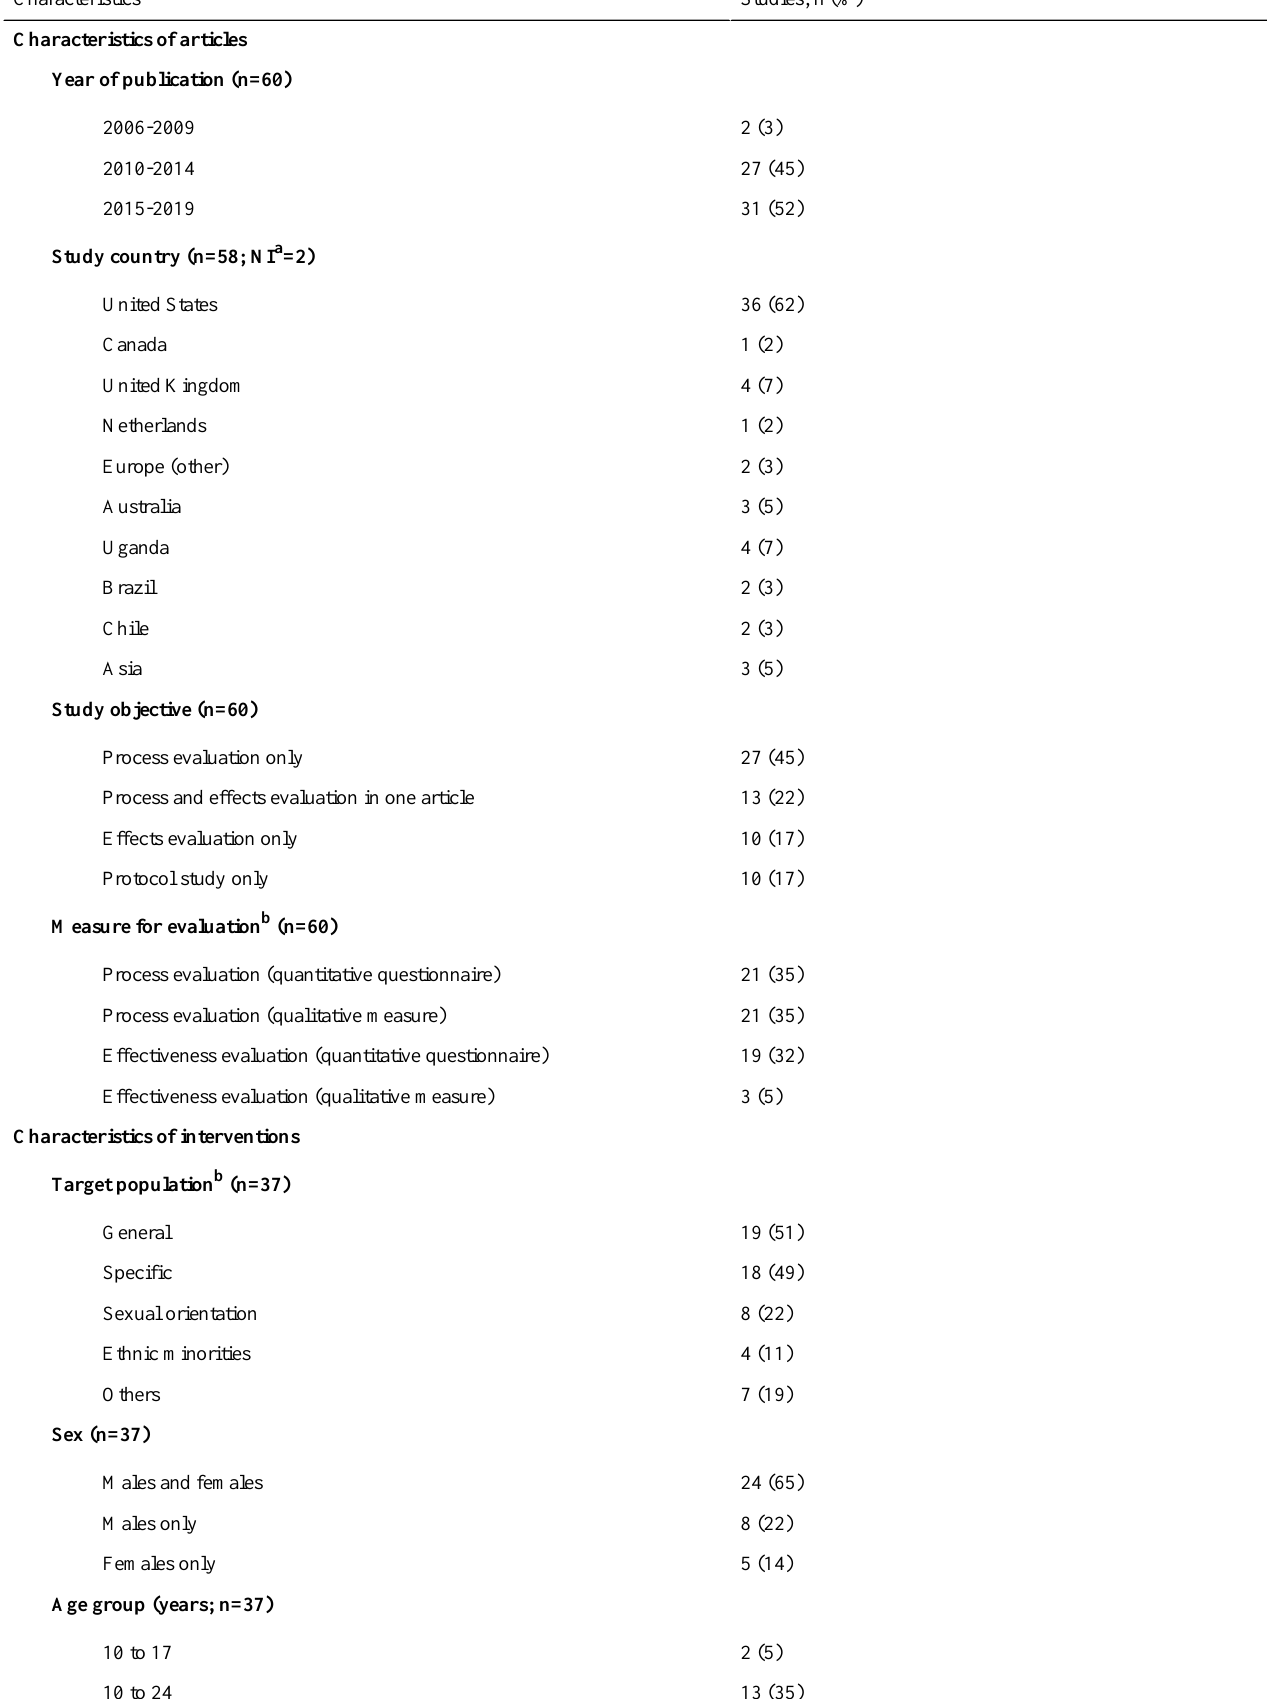
Table 1. Description of the characteristics of the 60 articles and the 37 interventions.